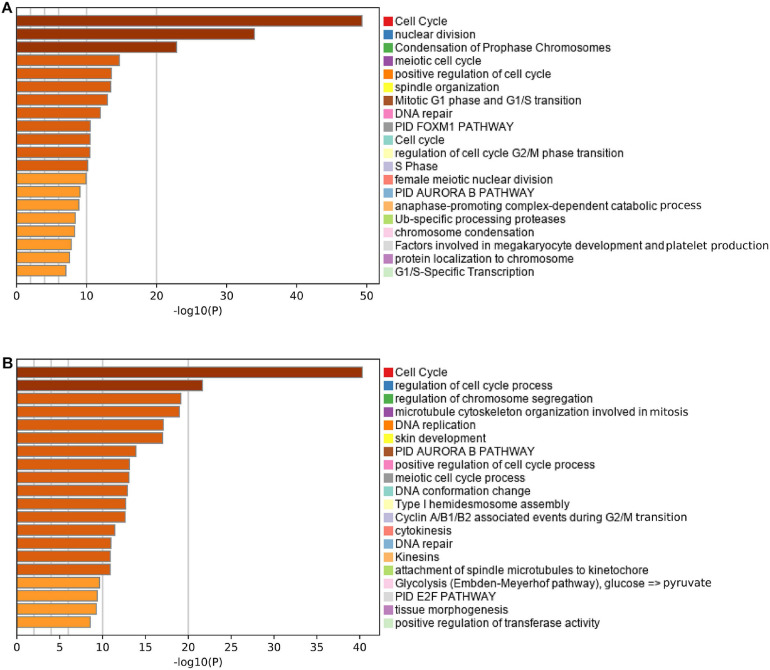
Functional annotation and pathway enrichment. (A,B) Enriched pathways of the genes positively correlated with risk score in MTAB-6134 cohort and TCGA cohort.